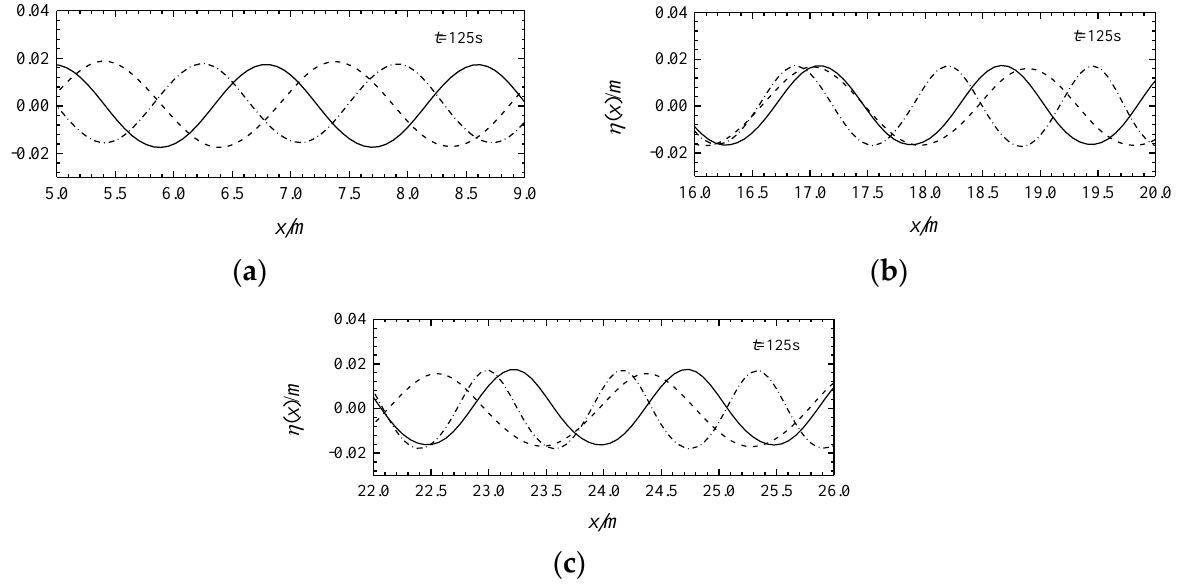
Figure 19. MIKE 21 BW model downstream (dotted line), no-current (solid line), and counter-current (dotted line) simulated instantaneous wavefront in different positions such as (a), (b),(c) . Table 4. Variation of wavelength at different positions under the action of water currents.